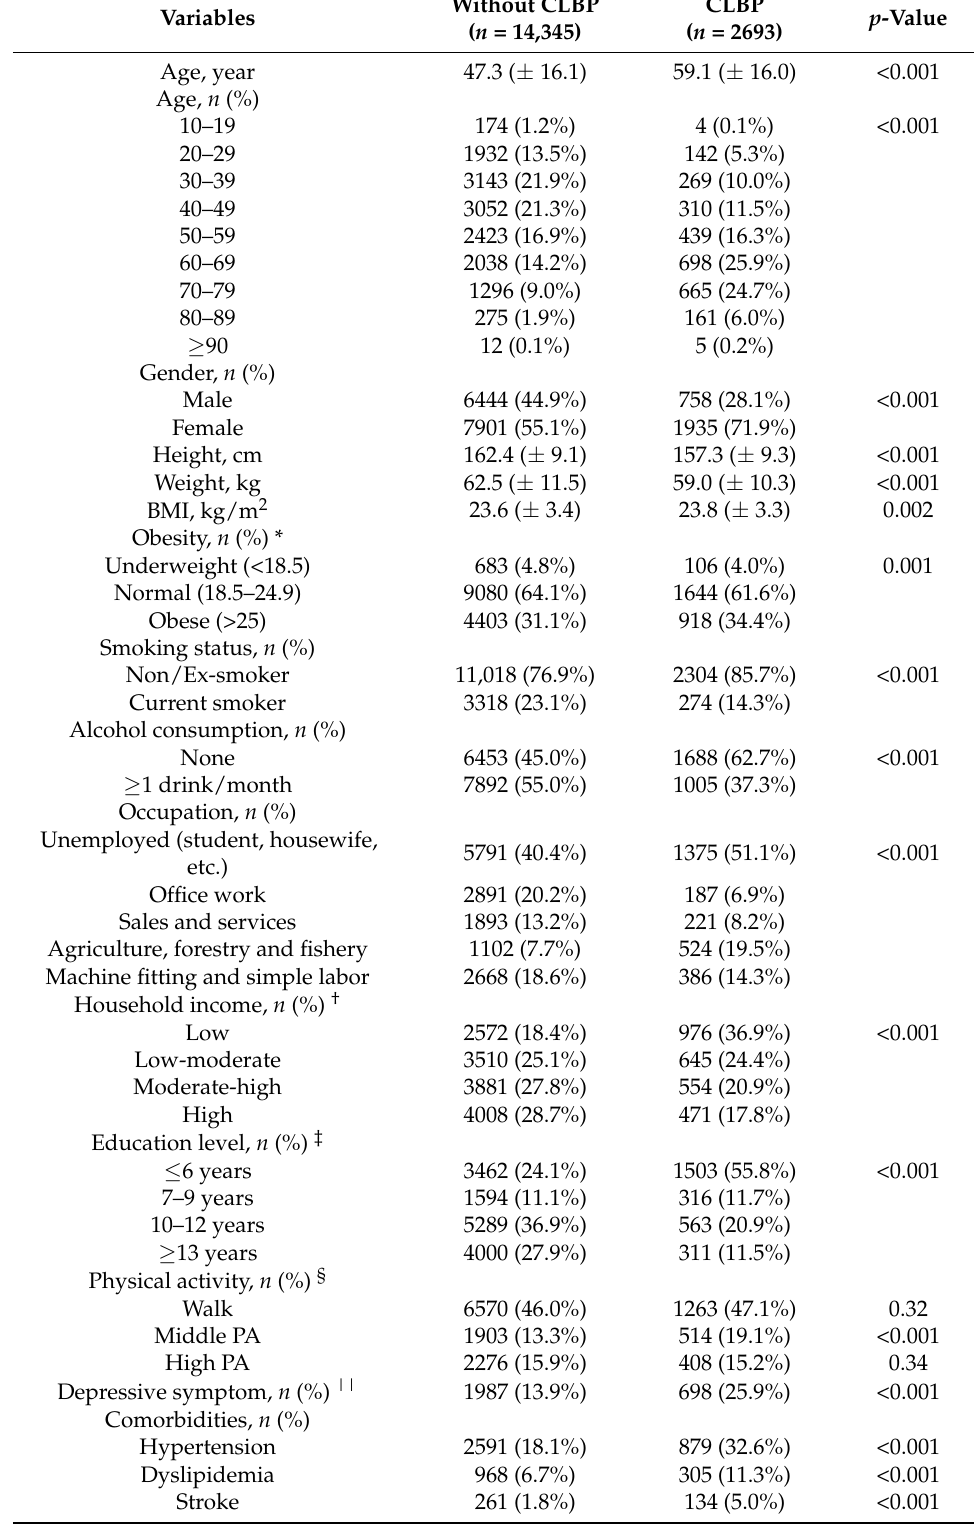
Table 1. Characteristics of the study population according to chronic low back